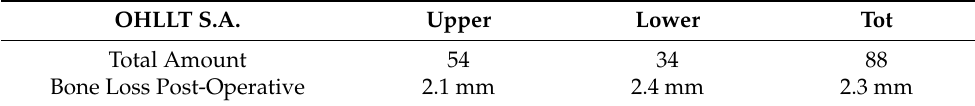
Table 4. Bone loss post-operative (t1) for implants with surgical approach (S.A.). OHLLT S.A. Upper Lower Tot Total Amount 54 34 88 Bone Loss Post-Operative 2.1 mm 2.4 mm 2.3 mm